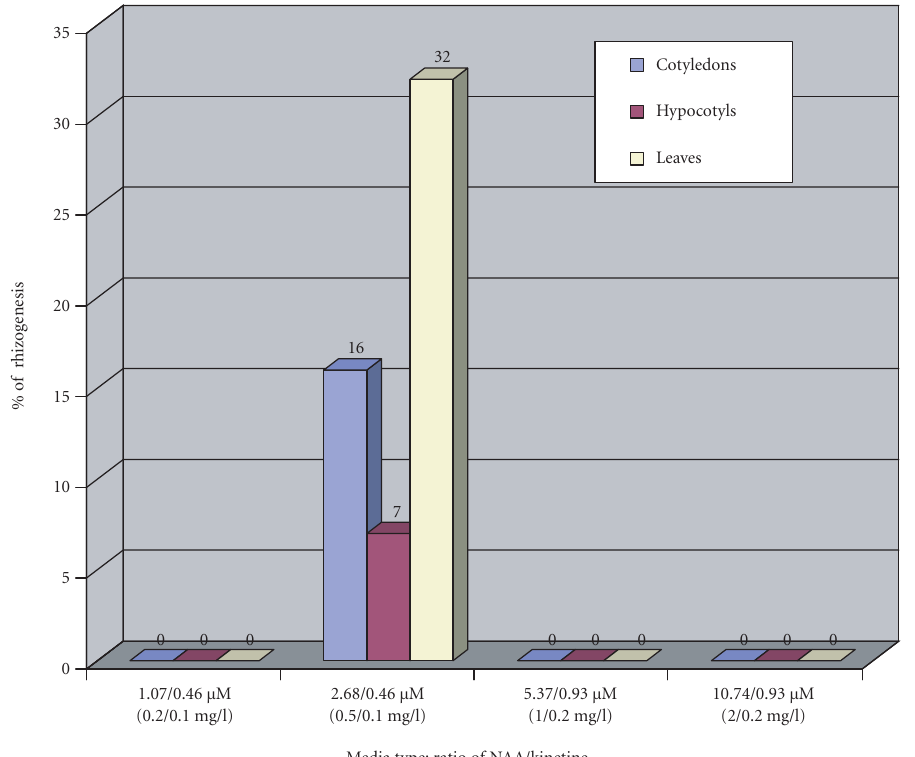
Figure 5: Percentages of roots obtained from callus of Papaver orientale splendidissimum in function of plant growth regulator combinations NAA/kinetin after four months of culture.